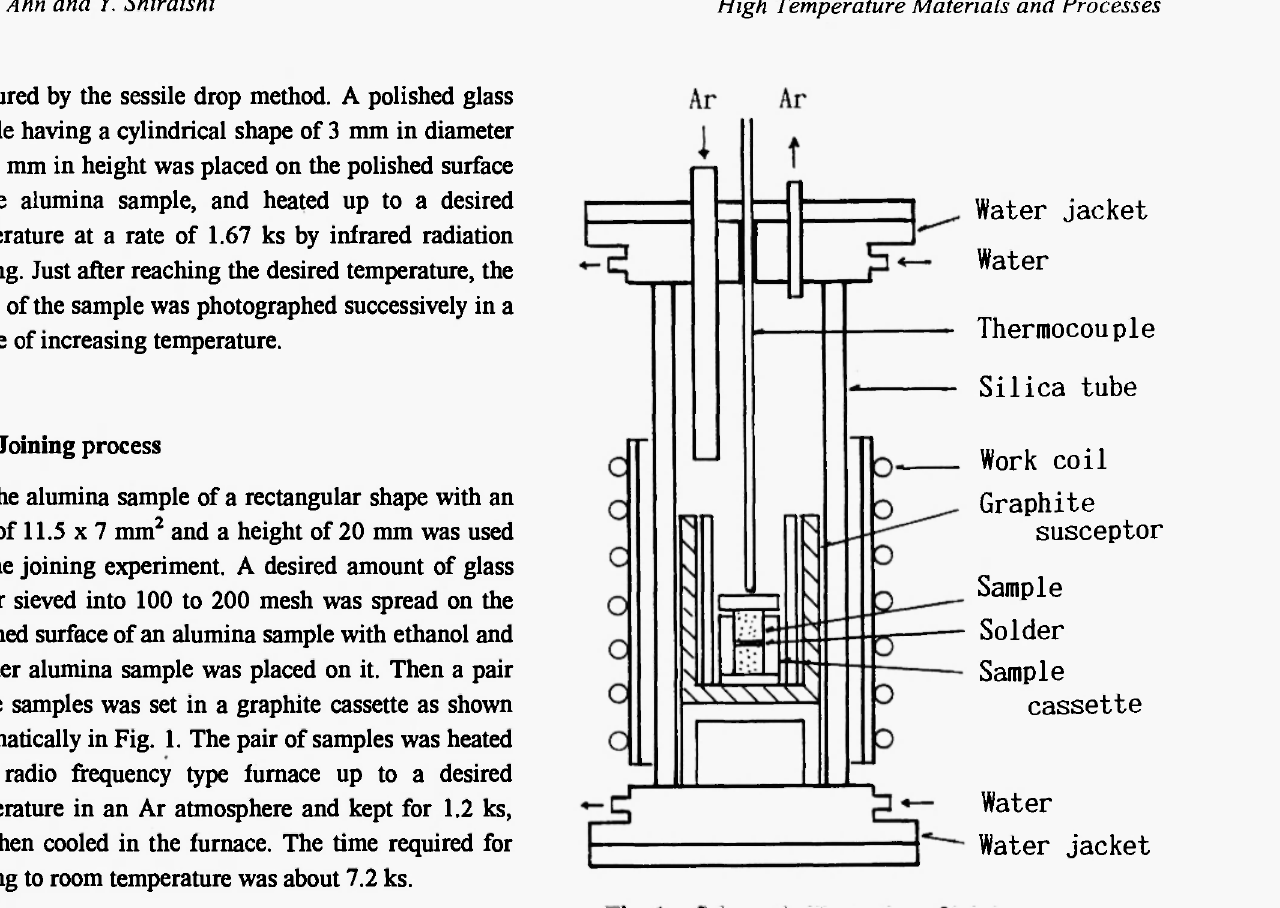
Fig. 1: Schematic illustration of joining apparatus.